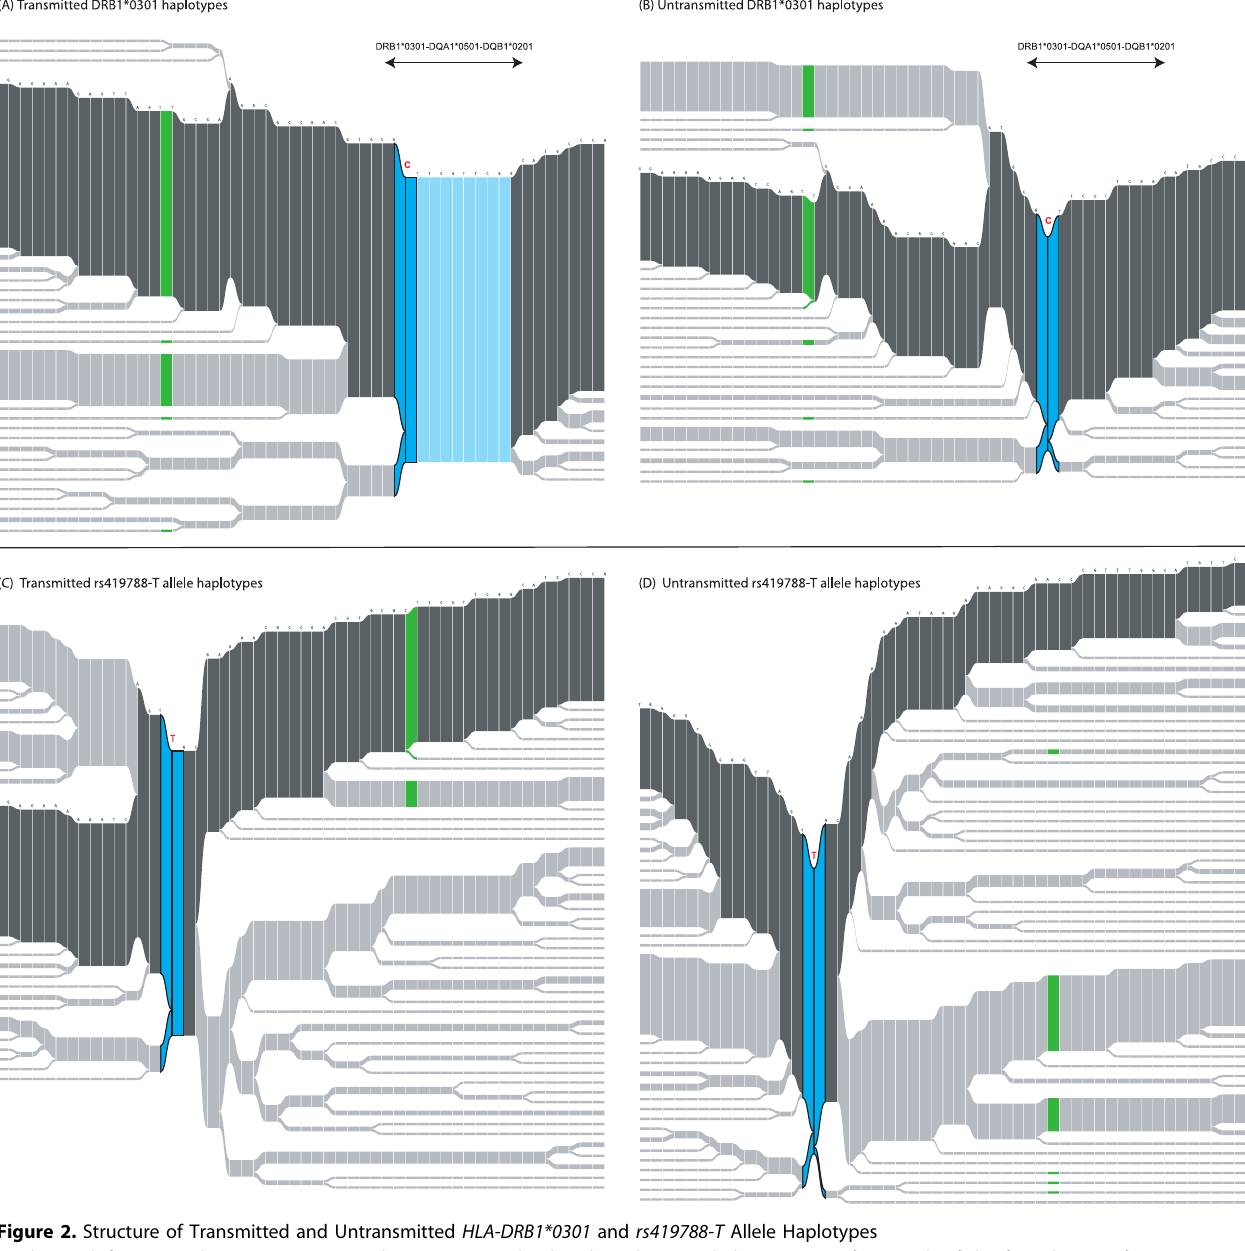
Figure 2. Structure of Transmitted and Untransmitted HLA-DRB1*0301 and rs419788-T Allele Haplotypes Haplotype bifurcation plots were constructed using 120 randomly selected parental chromosomes from each of the four datasets for comparative purposes except (B),where there were only 90 chromosomes in the entire dataset: (A) T HLA-DRB1*0301 haplotypes, (B) UT HLA-DRB1*0301 haplotypes, (C) T rs419788-T allele haplotypes, and (D) UT rs419788-T allele haplotypes. The allelic composition of the most common haplotype in each subset is shown: the core allele is represented as a dark blue double bar indicating haplotypes to the right and to the left of the core; otherwise, the common haplotype is depicted by dark grey bars. In parts (A) and (B), the rs419788-T allele in class III that shows association independent of HLA-DRB1*0301 in our cohort is indicated in green, while in parts (C) and (D), the allele HLA-DRB1*0301 is shown in green. The key difference between HLA-DRB1*0301 T and UT haplotypes lies within the class II region of the MHC. All HLA-DRB1*0301 T haplotypes are identical across a 180 kb region defined by eight SNPs (light blue), whereas the corresponding region within UT HLA-DRB1*0301 haplotypes exhibits significant recombination. This conserved class II interval encompasses only three expressed genes: HLA-DRB1 , HLA-DQA1 , and HLA-DQB1 . Given the strong LD exhibited by HLA-DRB1*0301 haplotypes, the allelic composition of this risk region is known to be HLA-DRB1*0301-HLA-DQA1*0501-HLA-DQB1*0201 . Both T and UT rs419788-T allele haplotypes show similar structure overall. The rs419788-T allele is clearly present on HLA-DRB1*0301 and non- HLA-DRB1*0301 -containing haplotypes, lending credence to our observation that rs419788-T or another variant in LD with it constitutes an association signal independent of HLA-DRB1*0301 in our UK SLE cohort. (A) 120 from a total of 176 parental chromosomes, (B) 90 from a total of 90 parental chromosomes, (C) 120 from a total of 284 parental chromosomes, and (D) 120 from a total of 182 parental